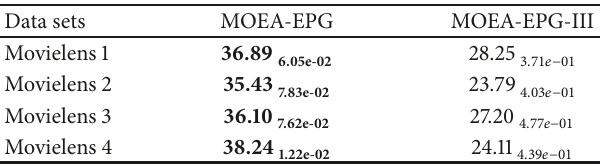
Table 6: HV comparison results of MOEA-EPG and MOEA-EPG- III in the accuracy-novelty